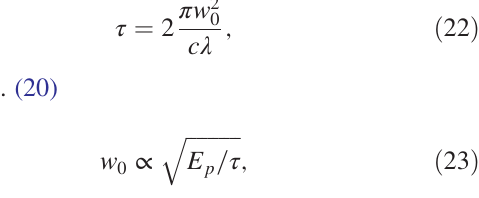
TABLE III. Effective photon production ( μ for different scenarios.